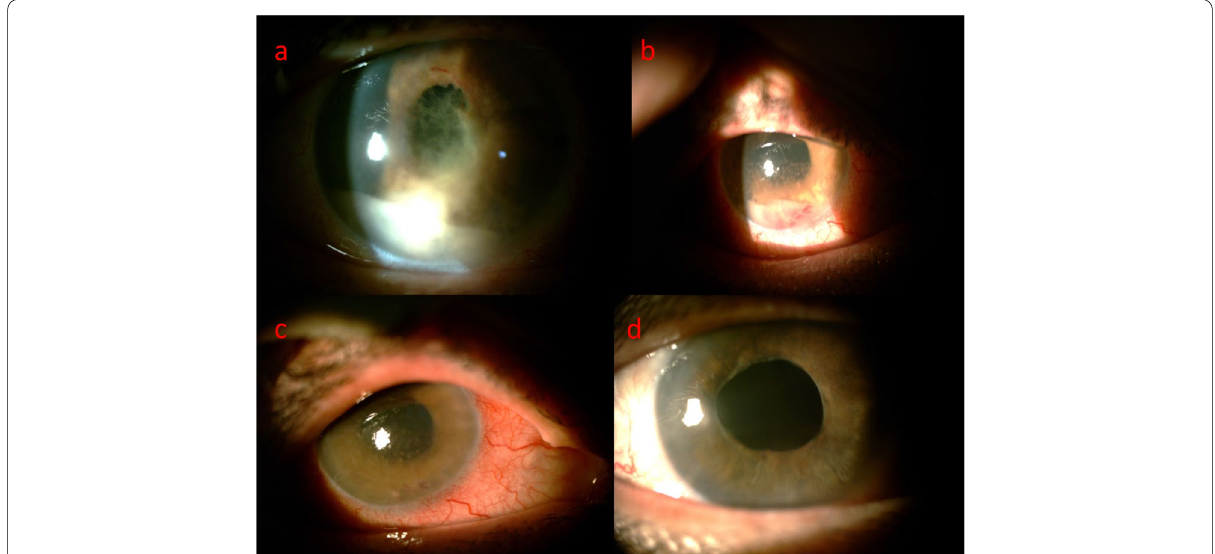
Fig. 1 Slit photography of the right eye; hypopyon anterior uveitis with severe fibrinous reaction following 2 months therapy as a uveitis